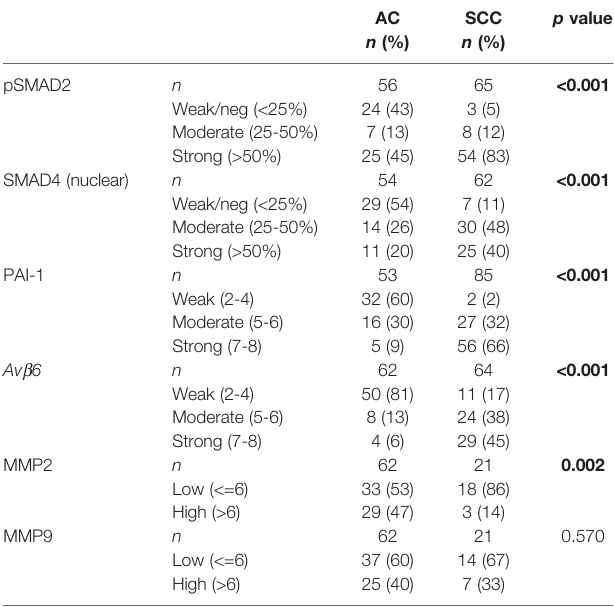
Protein expression scores. A comparison between AC and SCC of protein expression scores of pSMAD2, nuclear SMAD4, PAI-1, a v b 6, MMP2 and MMP9. Values are presented in number of patients (percentage). P-values are calculated using Chi- squared test. Bold value indicates signi fi cance (p <0.05). AC, adenocarcinoma; SCC, squamous cell